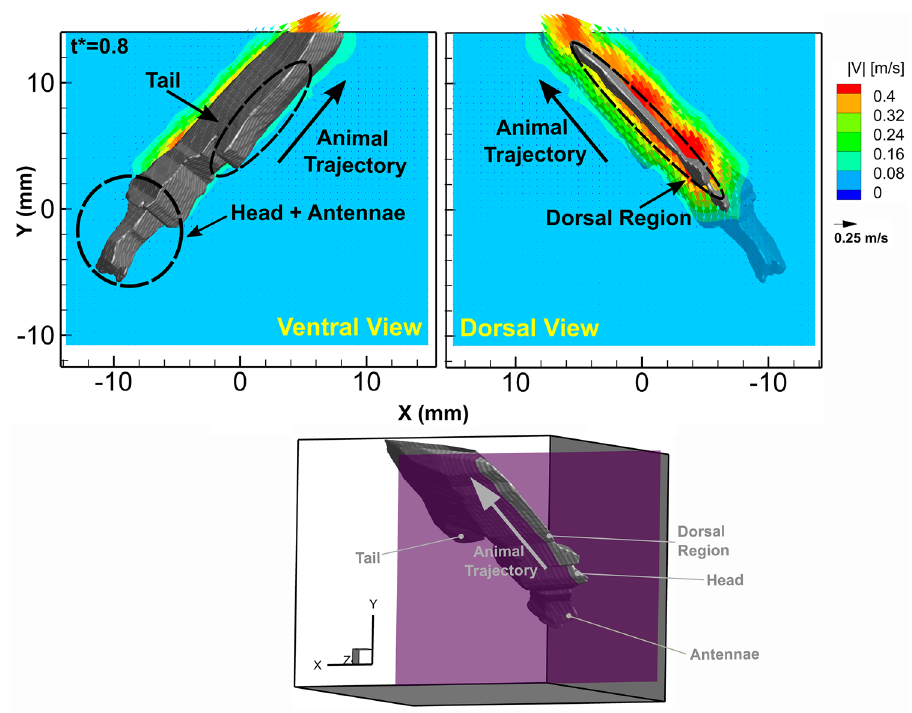
Figure 4. Snapshot at t* = 0.8 of the fluid velocity field in a XY plane (for Z = 5.86 mm) bisecting the dorsal ridge of the animal while E. superba moves through the plane after the abdominal closure and increase in velocity. The plane is shown from both the ventral view and the dorsal view, where the dorsal ridge of the animal is visible. The velocity vectors are colored to indicate the fluid velocity magnitude, as defined in the legend. The XY plane was extracted from the full 3D vector flow field. To help to orient the planar field, a small 3D reconstruction of the slice orientation with respect to the 3D visual hull is shown in the bottom center of the figure.